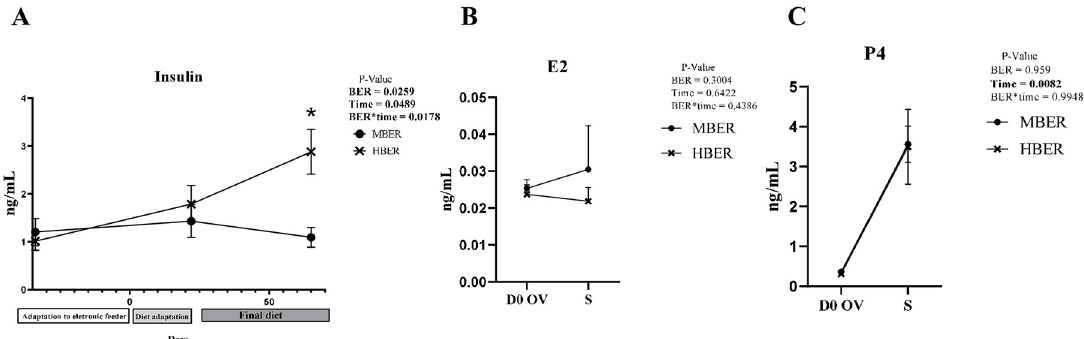
Fig 3. Serum insulin and reproductive hormones levels of Nellore cows during the experimental period. A. Insulin concentration. B. E2 concentration. C. P4 concentration. Standard error of the mean for body energy reserve, time and body energy reserve and time interaction. P-values are on the right top of the Figures. � Statistical difference ( P < 0.05). D0 OV: day scheduled for ovulation. S: day of slaughter.